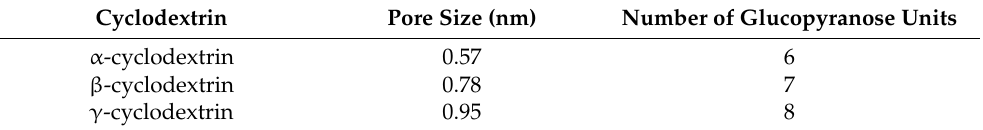
Table 1. Cyclodextrin Characteristics